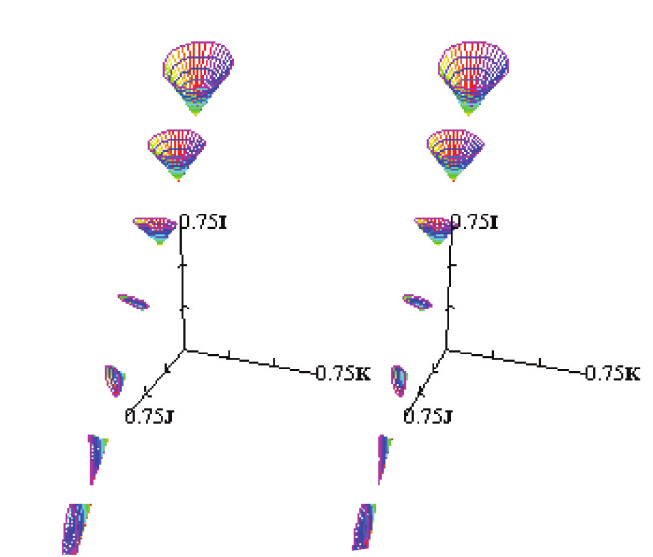
Figure 4 : Surfaces of tilted power in symmetric di- optric power space for thin lenses of stigmatic and astigmatic types. All lenses, in air ( n* =1), have re- fractive index 1.5 and the origin is null power. For all surfaces, θ and φ are incremented in small intervals, namely [0:2.5:180)° and [0:5:60)°